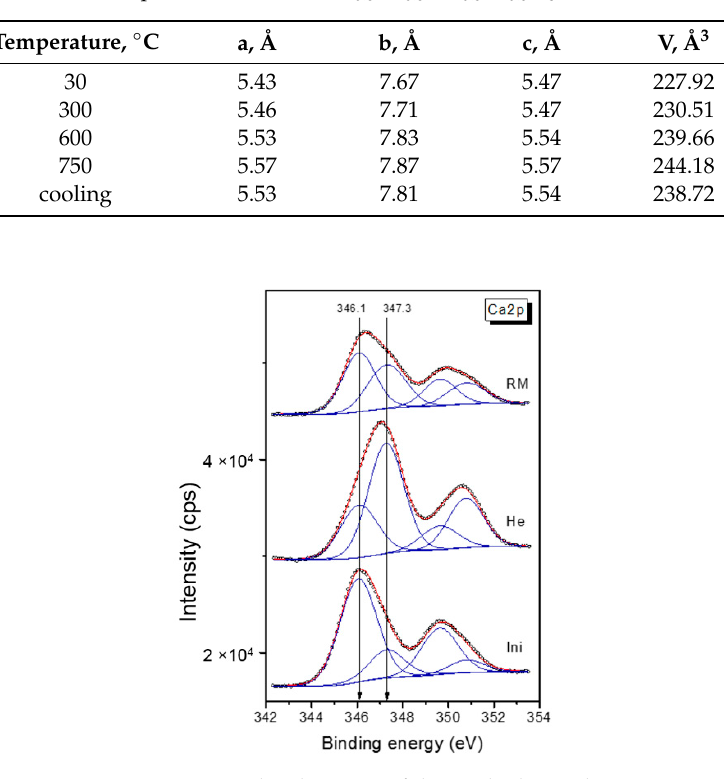
Figure 8. Ca2p level spectra of the studied samples.